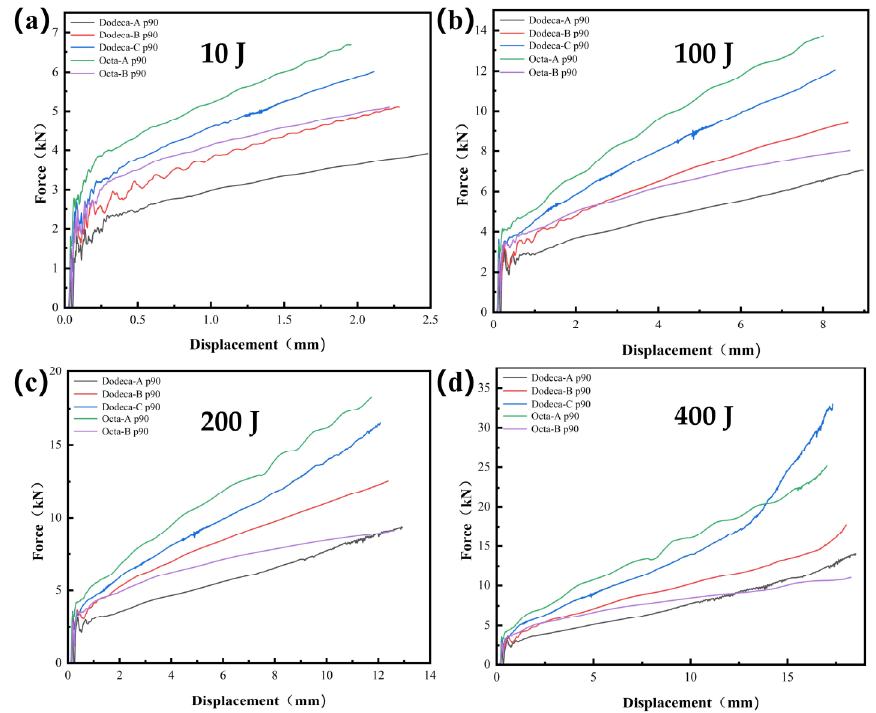
Figure 5. Force-displacement curves of 90%-porosity structures tested at different impact energies: ( a ) 10 J, ( b ) 100 J, ( c ) 200 J and ( d ) 400 J.